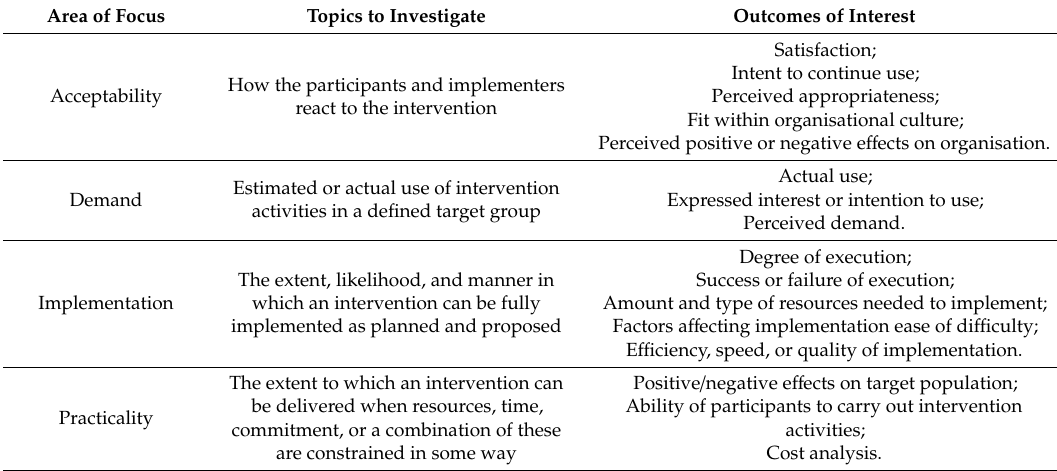
Table 1. Bowen’s feasibility study